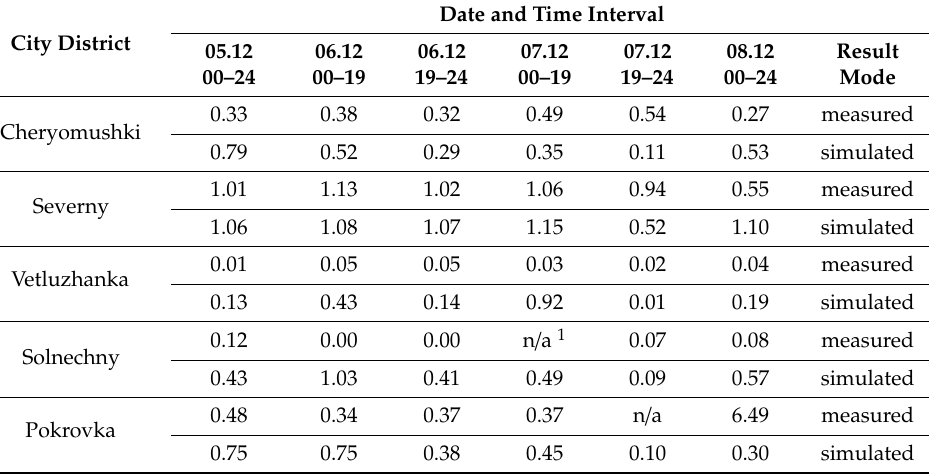
Table 9. NO 2 concentrations in shares of peak MPC (200 µ g / m 3